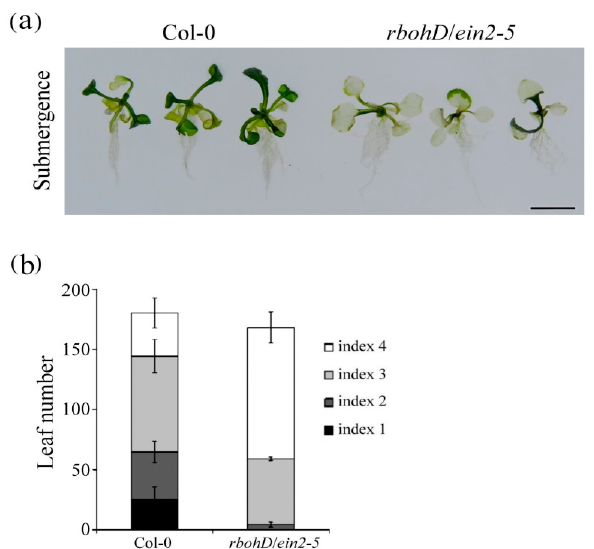
Figure 6. Sensitivity of the rbohD / ein2-5 double mutant to submerged conditions. ( a ) Phenotypes of 7-day-old wild-type plants and rbohD / ein2-5 double mutant seedlings after 12 d of submergence and 5 d of subsequent recovery. Bar = 1 cm. The photograph provides the results for three independent seedlings. ( b ) Quantification of the phenotype. Levels of damage were defined using an index based on the percentage of chlorotic leaves. Index 1 = 100% green leaves, Index 2 = over 50% green leaves, Index 3 = less than 50% green leaves, and Index 4 = 0% green leaves. The same results were obtained from three independent experiments ( n ≥ 25).